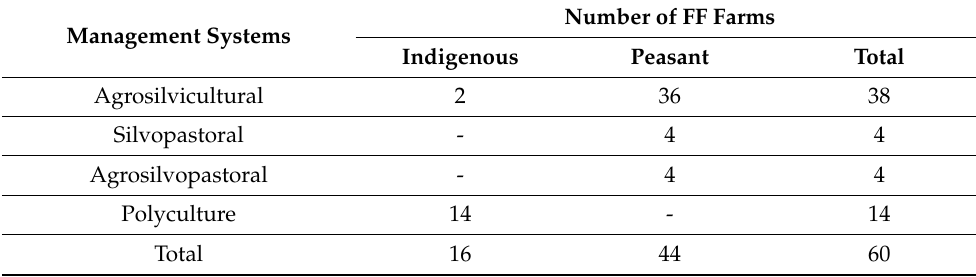
Table 3. Management systems